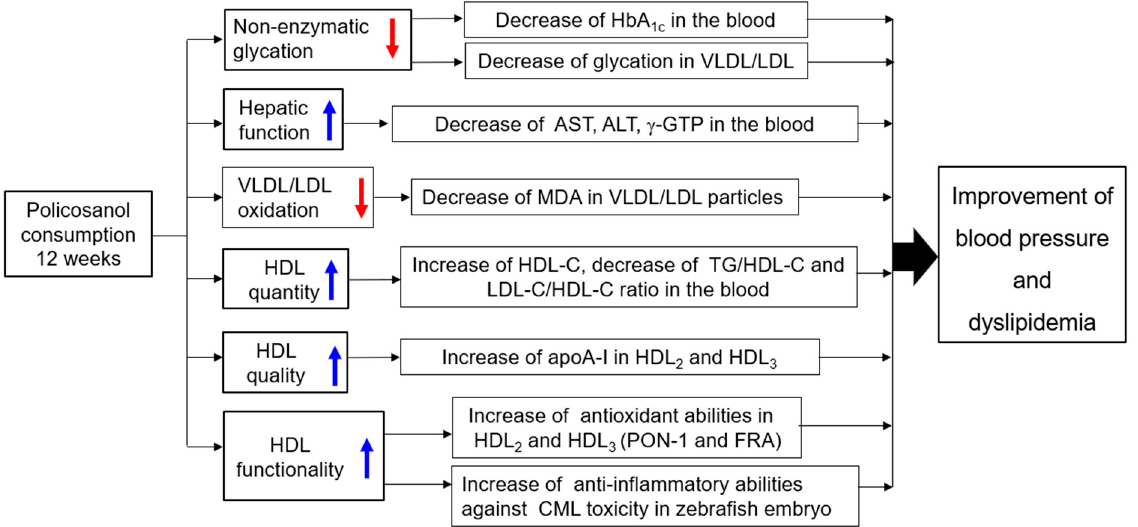
Figure 9. Proposed mechanism of policosanol to improve blood pressure and dyslipidemia after 12 weeks of consumption. apoA-I, apolipoprotein A-I; AST, aspartate transferase; ALT, alanine aminotransferase; CML, carboxymethyllysine; FRA, ferric ion reduction ability; γ -GTP, gamma-glutamyl transpeptidase; HbA1c, hemoglobin A1c; LDL, low-density lipoproteins; MDA, malondialdehyde; PON-1, paraoxonase-1; TC, total cholesterol; TG, triglyceride; VLDL, very low-density lipoproteins.